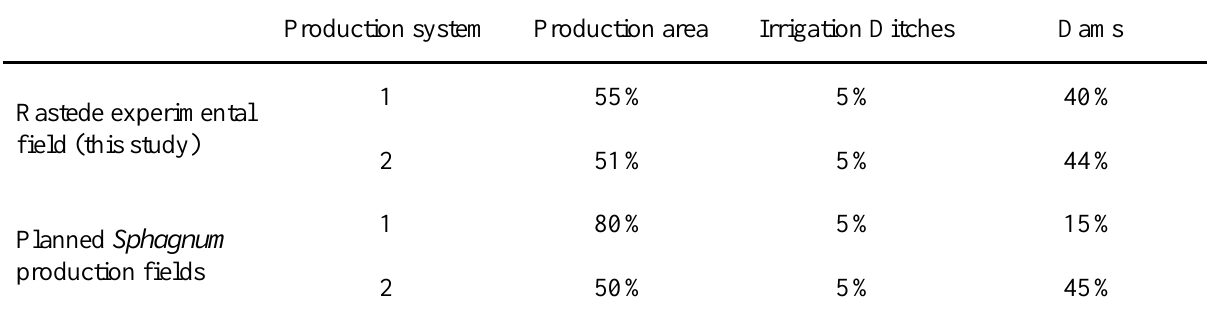
Table 1. Composition of the two production systems in % area of the different structural components (production area, ditches, and dams) for the realised experimental field and planned commercial Sphagnum farming fields. Production System 1: Management with site-adapted machinery directly on the Sphagnum production area, Production System 2: Management exclusively from the